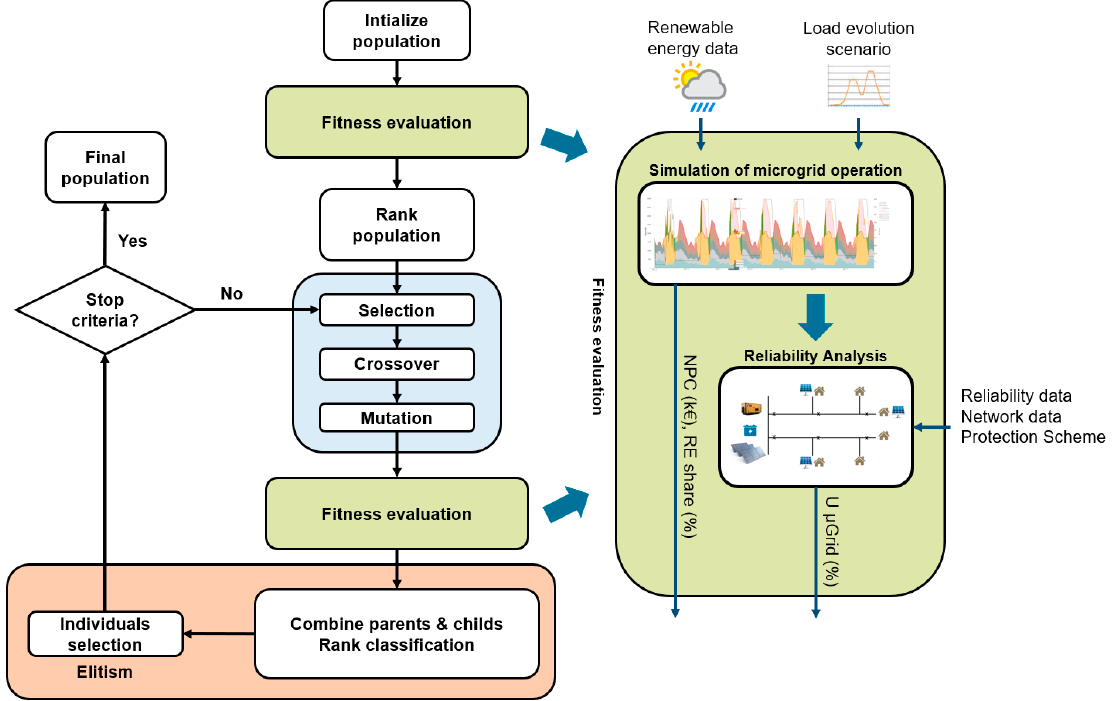
Figure 2. Global multi-objective optimization method developed using the NSGA-II algorithm.